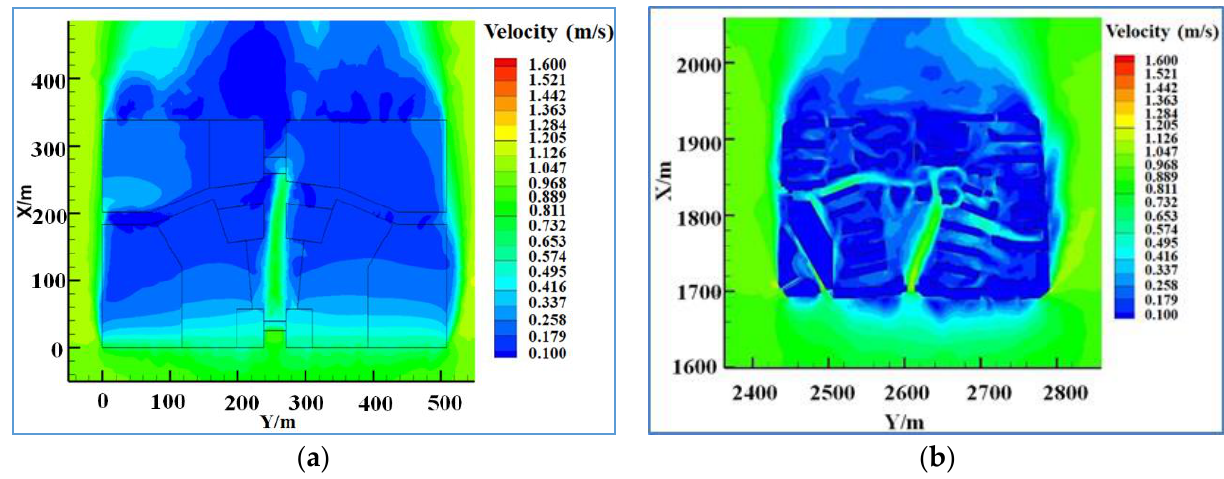
Figure 6. The contours of wind velocity in plane z = 2 m: ( a ) macroscale porous media model simulation, ( b ) microscale simulation (for southerly wind).